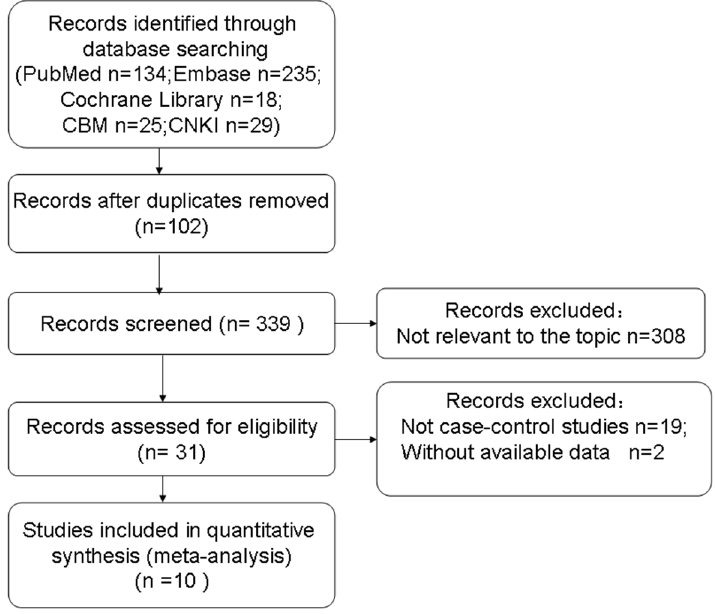
Fig 1. Flow diagram of study selection for the meta-analysis. CBM, Chinese Biological Medical Database. CNKI, Chinese National Knowledge Infrastructure Database.